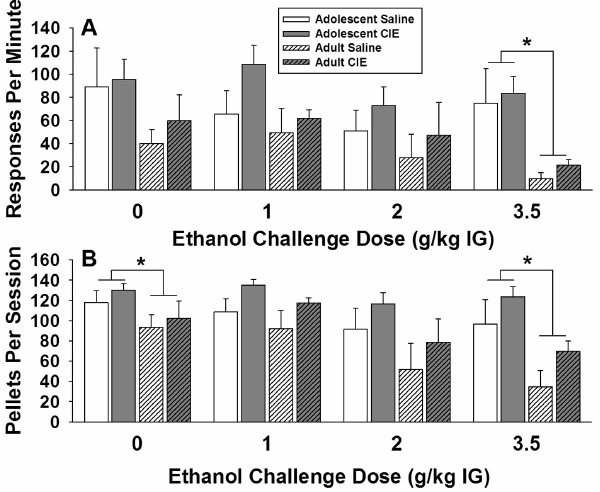
Figure 8. Effects of chronic intermittent ethanol or saline exposure during adolescence or adulthood on response rate (top panel, A) and average pellets per session (bottom panel, B) after an acute ethanol challenge. Data are expressed as group mean + SEM (n=6 adolescent-saline, n=6 adolescent-CIE, n=5 adult- saline, n=5 adult-CIE). Asterisks denote a significant difference between rats exposed to CIE or saline as adults versus adolescents during acute ethanol challenge at specific doses (simple effects ANOVA, p ,